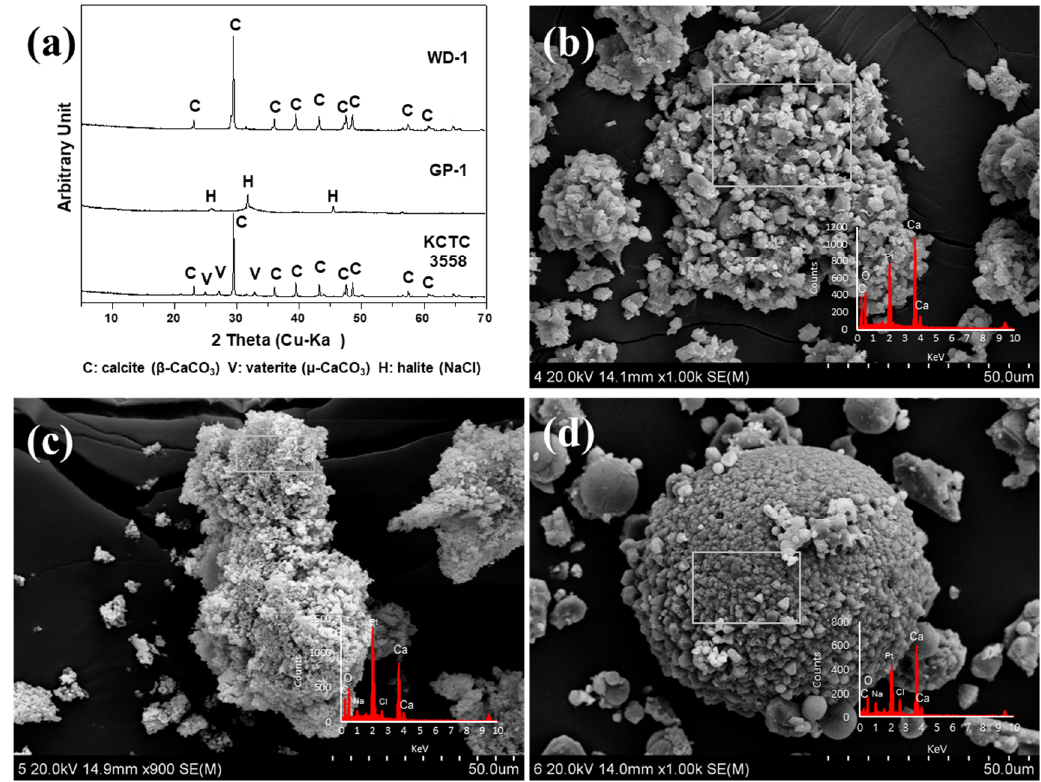
Figure 4. ( a ) XRD patterns and SEM-EDS images of Ca-carbonates formed by microorganisms using Ca-lactate: ( b ) WD-1, ( c ) GP-1, and ( d ) KCTC 3558.